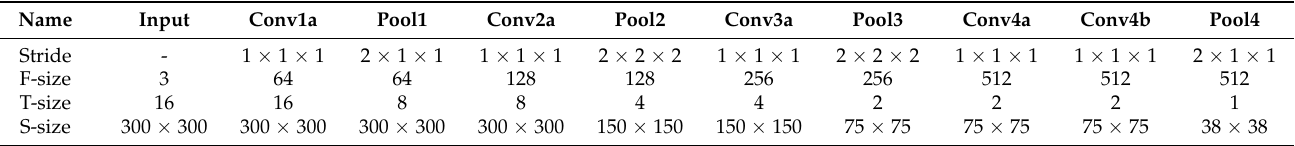
Table 1. The 3D ConvNet used in the proposed model. All convolution layers and pooling layers are three-dimensional. All 3D convolution kernels are 3 × 3 × 3 with stride 1 in both spatial and temporal dimensions. F-size, T-size, and S-size are short for feature size, temporal size, and spatial size,